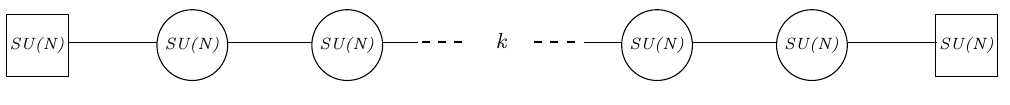
Figure 6. The quiver encoding the dynamics of the third example CFT. The long tail of colour SU( N ) ends with a (cid:13)avour